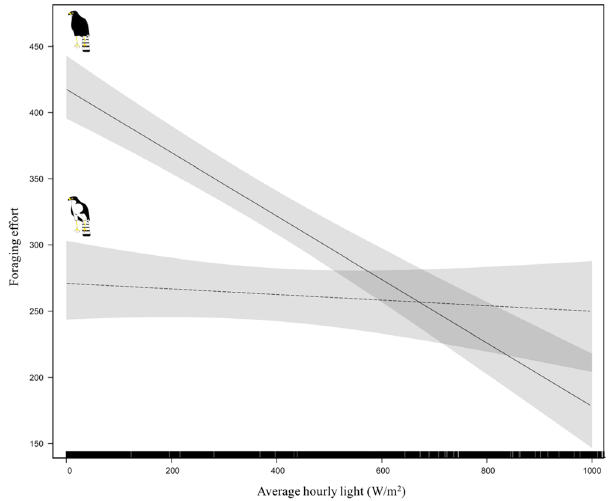
Figure 2. Foraging effort, measured as the average hourly distance travelled (meters) by individuals outside of the core nesting area (10% kernel estimate) with 95% confidence intervals. We detected a significant interaction between light levels and morph, with foraging effort decreasing as conditions became brighter for dark morphs. The same trend was apparent for white morphs but there was no significant difference in foraging effort across the light spectrum.